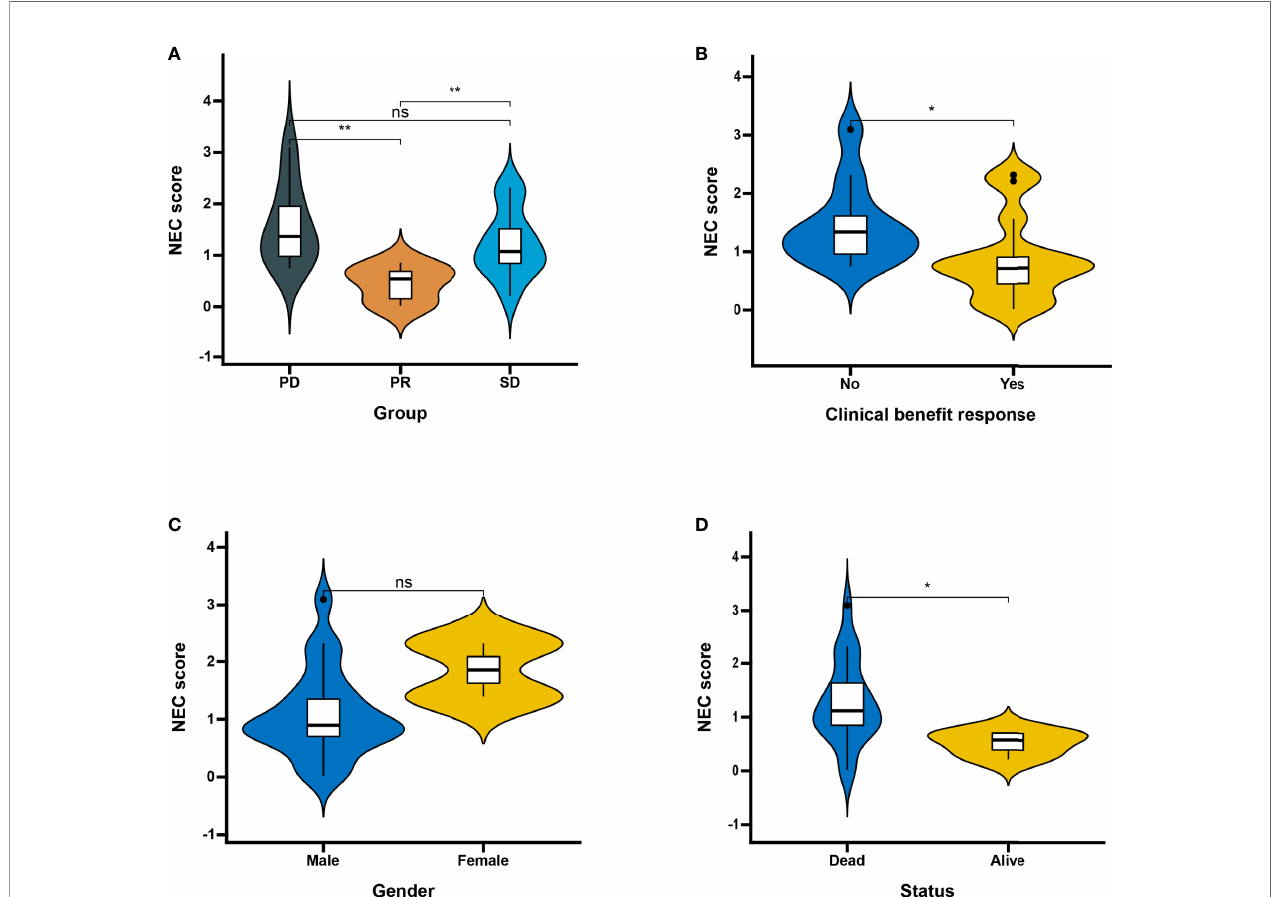
FIGURE 9 | Patient characteristics and NEC score of HCC treated with anti-PD-1 immmunotherapy. (A) Distribution of NEC score in distinct anti-PD-L1 clinical response groups. SD, stable disease; PD, progressive disease; PR, partial response (Student ’ s t test). The asterisks represented the statistical p-value (**P < 0.01). (B) Differences in NEC score between clinical response groups (Student ’ s t test). The asterisks represented the statistical p-value (*P < 0.05). (C) Differences in NEC score between gender groups (ns: not signi fi cant). (D) Differences in NEC score between status groups (Student ’ s t test). The asterisks represented the statistical p- value (*P <